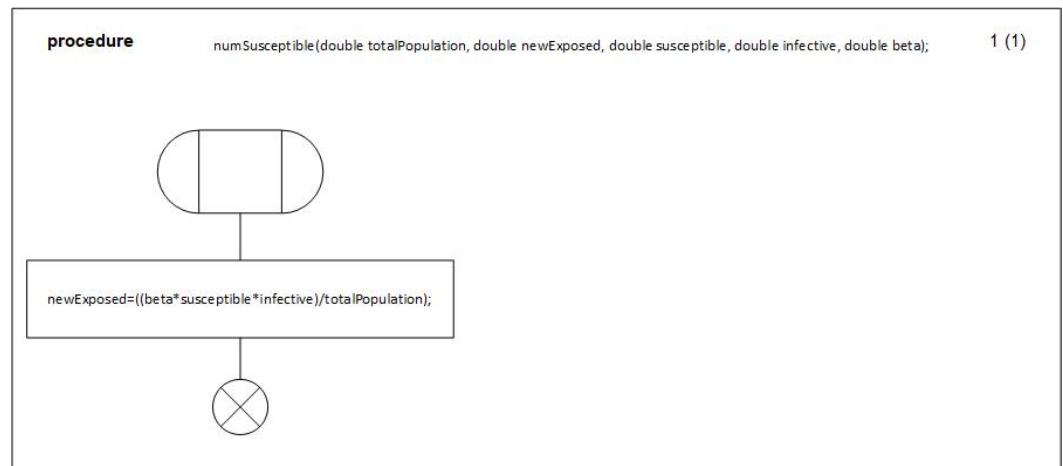
Figure 9. PROCEDURE numSusceptible that calculates the number of newExposed individuals.